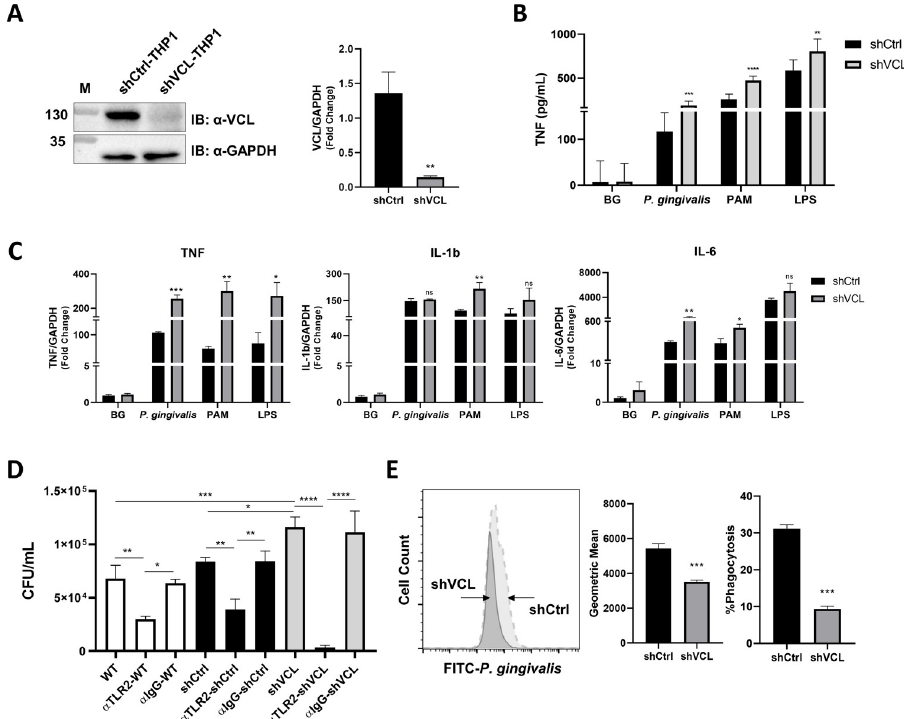
Fig 5. Cytokine production and bacterial survival in VCL knock-down macrophages. (A) Representative IB of VCL and GAPDH in whole cell lysates from shCtrl and shVCL-THP1 cells, and RT-PCR showing levels of VCL expression (B) TNF production by shCtrl and shVCL-THP1 cells challenged with P . gingivalis (MOI 10), PAM (10ng/mL), and LPS (10ng/mL) for 4 h, was measured by ELISA. Data are representative of five independent experiments. Unstimulated cells were used as controls (BG, background). (C) PMA-differentiated shCtrl and shVCL-THP1 cells were challenged with P . gingivalis (MOI 10), PAM (10ng/mL), and LPS (10ng/mL) for 4 h and mRNA levels of TNF, IL6, and IL1b were quantified by quantitative RT-PCR. mRNA from unstimulated cells collected at the same time point was used as background (BG). Data are representative of three independent experiments. (D) Intracellular P . gingivalis survival was determined in wild-type (WT) THP1, shCtrl-THP1 and shVCL-THP1 cells using the antibiotic protection assay as per methods with and without prior blocking of TLR2 using T2.5 anti-TLR2 mAb ( α TLR2) vs. IgG1 isotype control. CFU were enumerated after 7 days of anaerobic growth (ND, none detected). Data are representative of three independent experiments. (E) shCtrl and shVCL-THP1 cell phagocytosis of FITC-labelled P . gingivalis was measured by flow cytometry (percentage of fluorescent cells above background, and geometric mean of fluorescence). A sample histogram is shown on the left. Data representative of three independent experiments are shown on the right. (ns: non-significant; * P � 0.05; ** P � 0.01; *** P � 0.001; **** P �